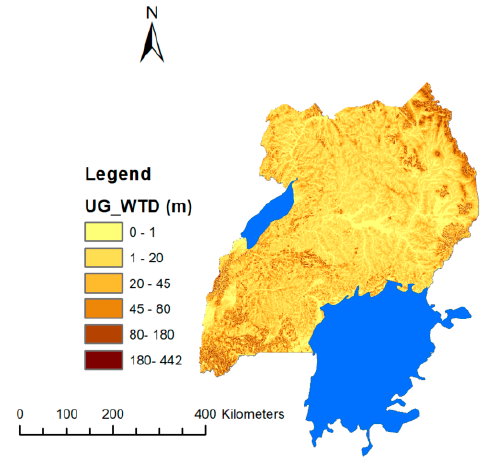
Figure 5. Water table depth (WTD) in m.